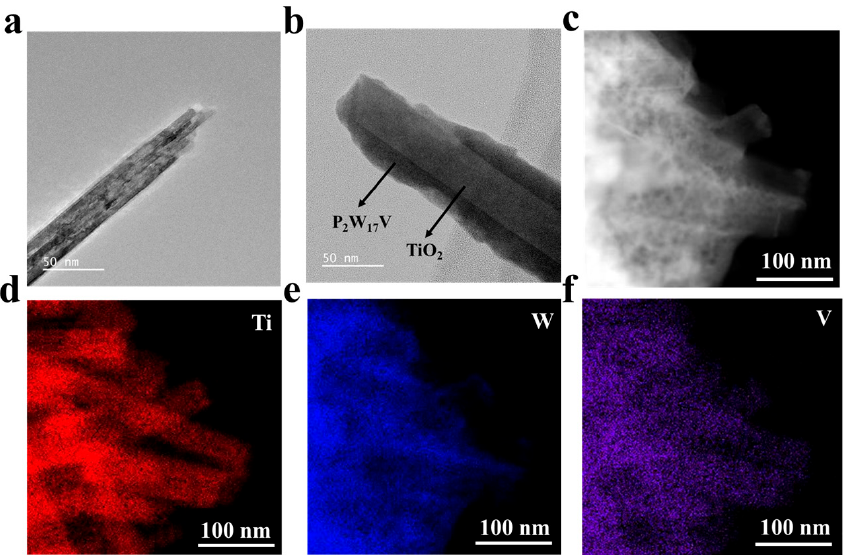
Figure 3. TEM images of TiO 2 nanowires ( a ) and NW − P 2 W 17 V ( b ); ( c – f ) EDS elemental mapping patterns of Ti, W, and V in the NW − P 2 W 17 V films.